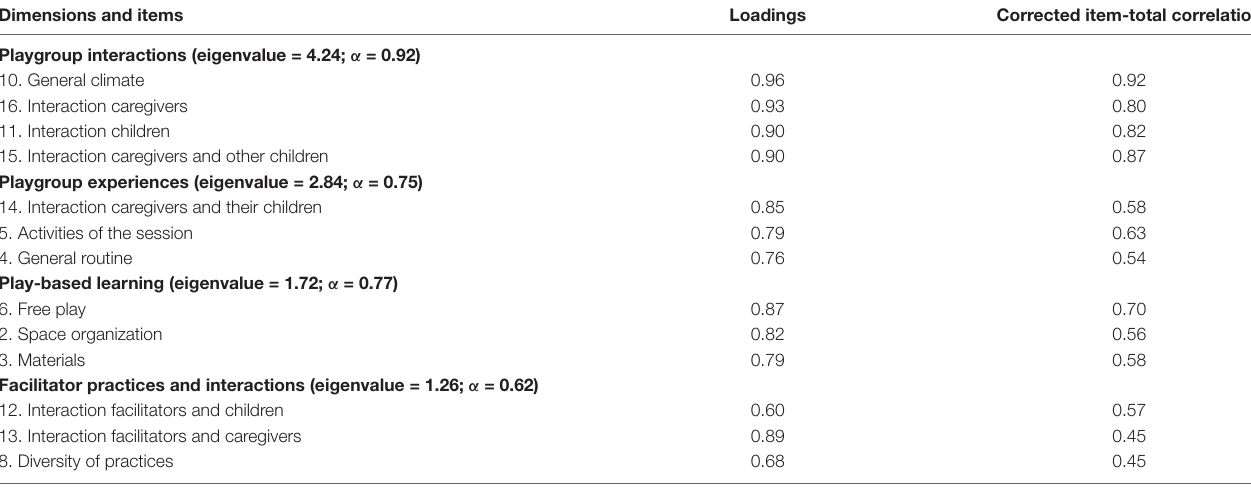
TABLE 7 | Principal components factor analysis of the PERS, corrected item-total correlation, and internal reliability of the measure’s dimensions. Dimensions and items Loadings Corrected item-total correlation Playgroup interactions (eigenvalue = 4.24; α = 0.92)